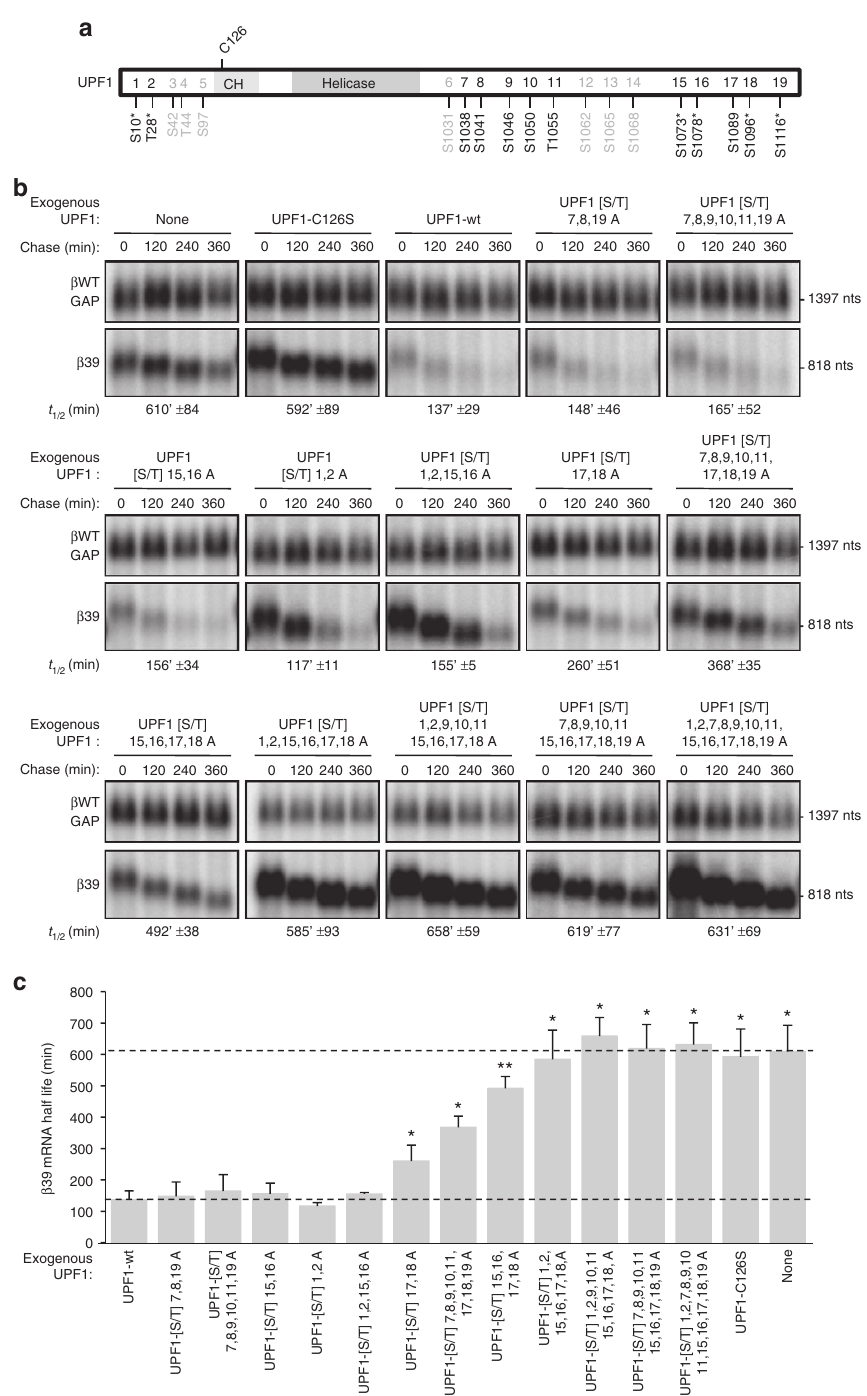
Figure 4 | Multiple UPF1 [S/T]Q motifs contribute to NMD. ( a ) Schematic representation of human UPF1 protein showing the amino acids mutated in this study (black); the position of the helicase domain and the cysteine/histidine-rich domain (CH) of UPF1 are indicated (not to scale). Numbers following amino-acid symbols correspond to the position in the UPF1 primary sequence (GenBank #NP_002902). Asterisk indicates confirmed phosphorylated sites. [S/T]Q motifs not investigated in this work are shown in grey. ( b ) Northern blots showing the decay of b 39 mRNA in HeLa Tet-Off cells depleted for endogenous UPF1 and expressing myc-tagged variants of UPF1 as indicated. Numbers above panels refer to minutes after tetracycline-mediated transcriptional shutoff of b 39 mRNA (chase). b 39 mRNA half-lives ( t 1/2 ) were calculated after normalization of levels of b 39 mRNA to levels of constitutively transcribed b -globin–GAPDH fusion mRNA ( b WT-GAP) and are given as averages ± s.e.m. from three independent experiments. Numbers on the right refer to RNA lengths in nucleotides (nts) excluding polyA-tails. ( c ) Graph showing half-lives calculated from experiments presented in b . Lower and upper dotted lines represent half-life values for wild-type UPF1 (Upf1-wt) and no add-back (None) conditions respectively. Error bars represent s.e.m. from three independent experiments. P values were calculated relative to Upf1-wt conditions using the paired two-tailed Student’s t -test; * P o 0.05 and ** P o 0.01.